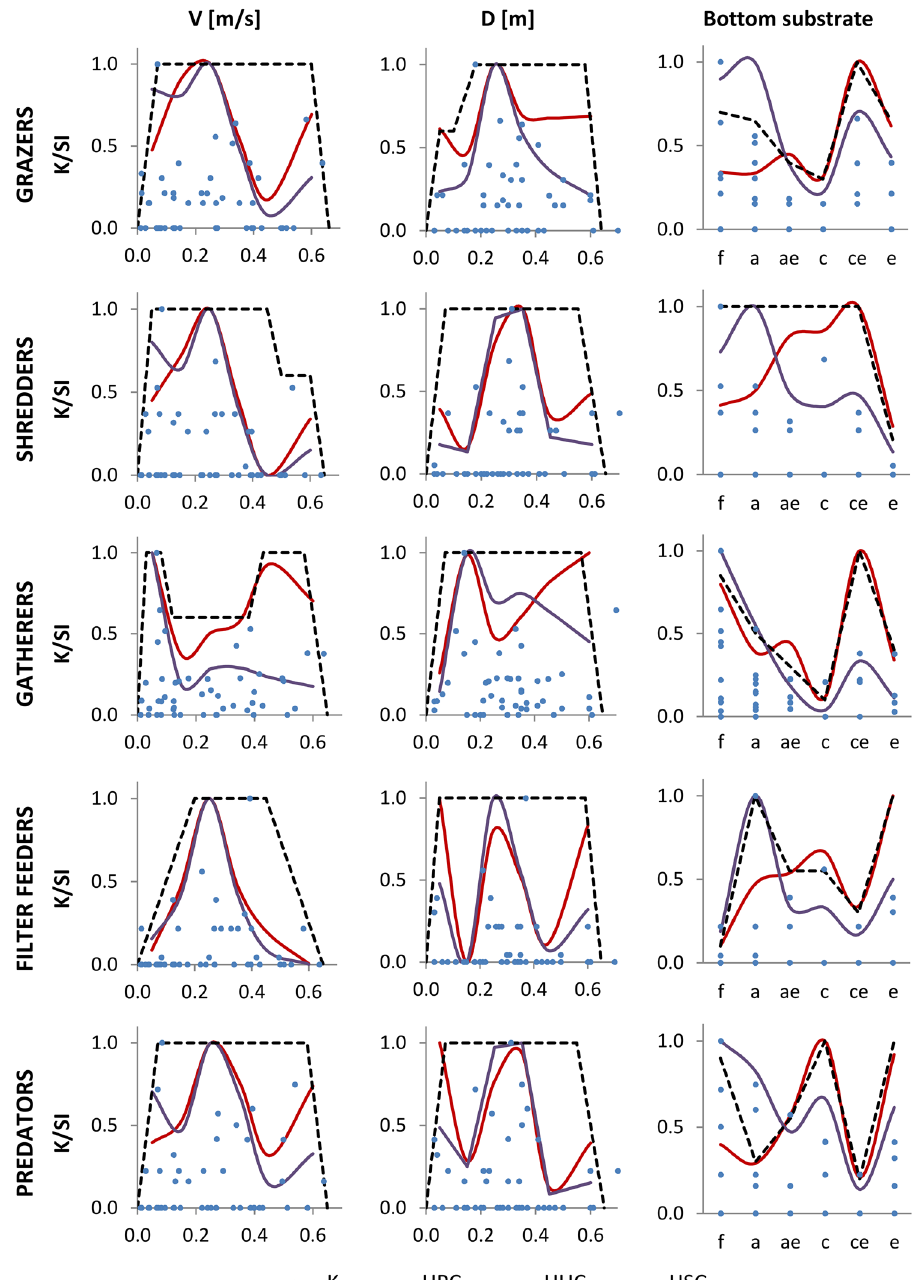
Figure 7. Habitat preference curves (HPCs), habitat utilization curves (HUCs), K parameter values, and final habitat suitability curves (HSCs) for FFGs. Categories of substrate: a—fine sand, c—medium sand, ae—fine sand with gravel, ce—medium sand with gravel, e—gravel,